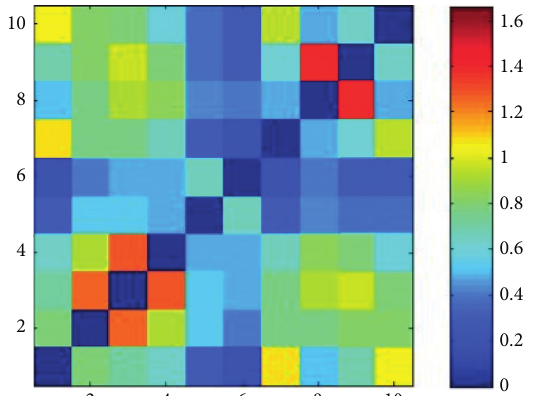
Figure 3: Colormap of industry sector indexes network in the post-pandemic period (the numbers on the horizontal and vertical axes represent the 10 sector indexes in Table 1).